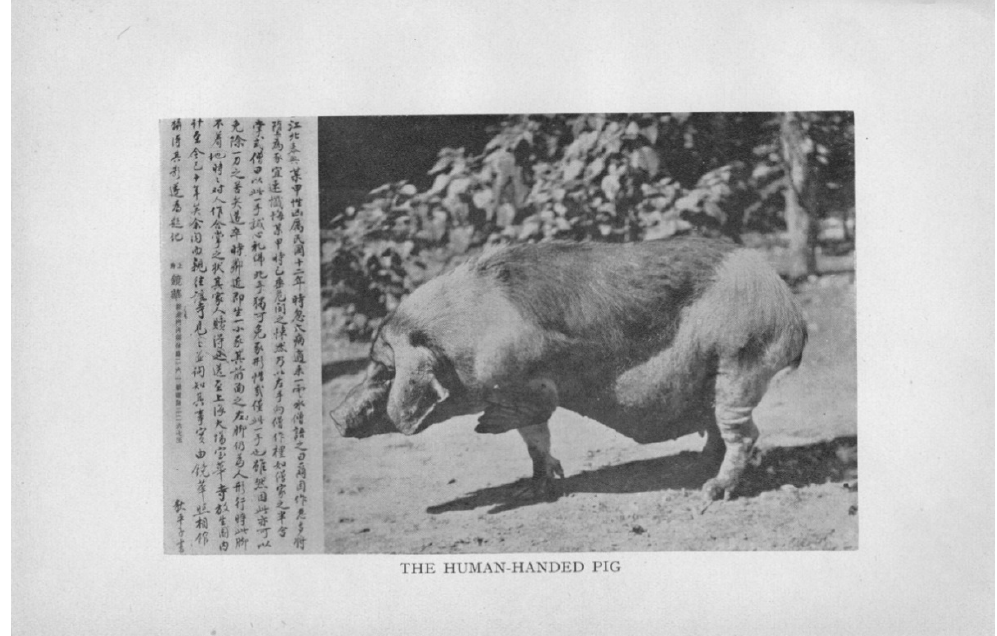
Figure 6. A photo of a pig with a human hand. Source: An Outline of Karma , 1940.